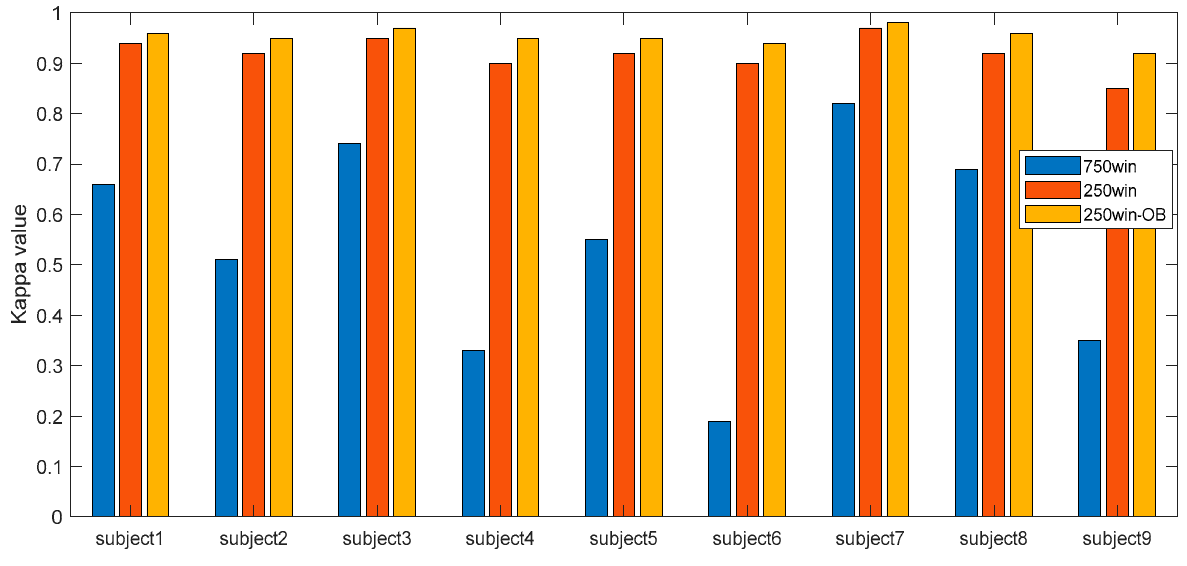
Figure 5. Kappa value according to window size.